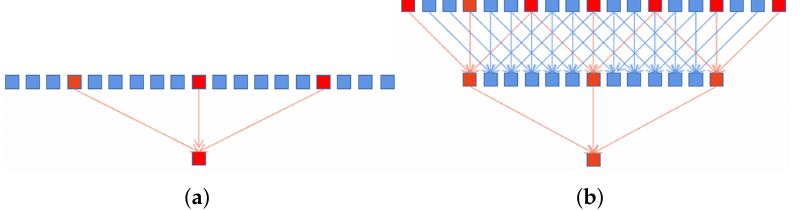
Figure 3. ( a ) Standard one-dimensional atrous convolution with dilation rate of 6. ( b ) Stacking an atrous convolution layer with different dilation